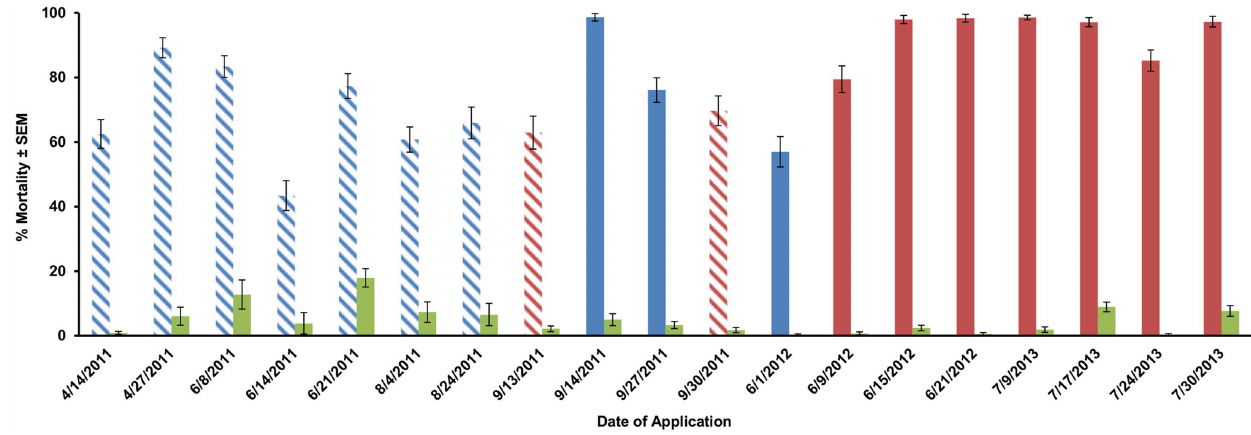
Figure 3. Efficacy summary of area-wide VectoBac WDG applications by date. Red=CSM2, blue=LV-8, green=control, dashed lines=400 g/ha, solid lines=800